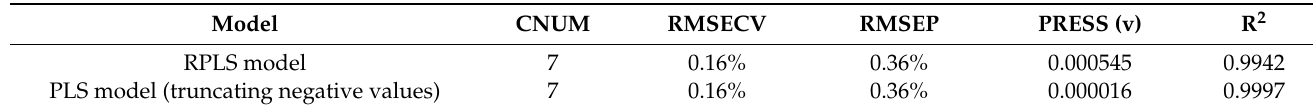
Table 2. FAME quantification PLS model results; rapeseed origin FAME/Wood origin diesel blends. Rapeseed origin FAME/Wood origin HVO (Bioverno) diesel blends.